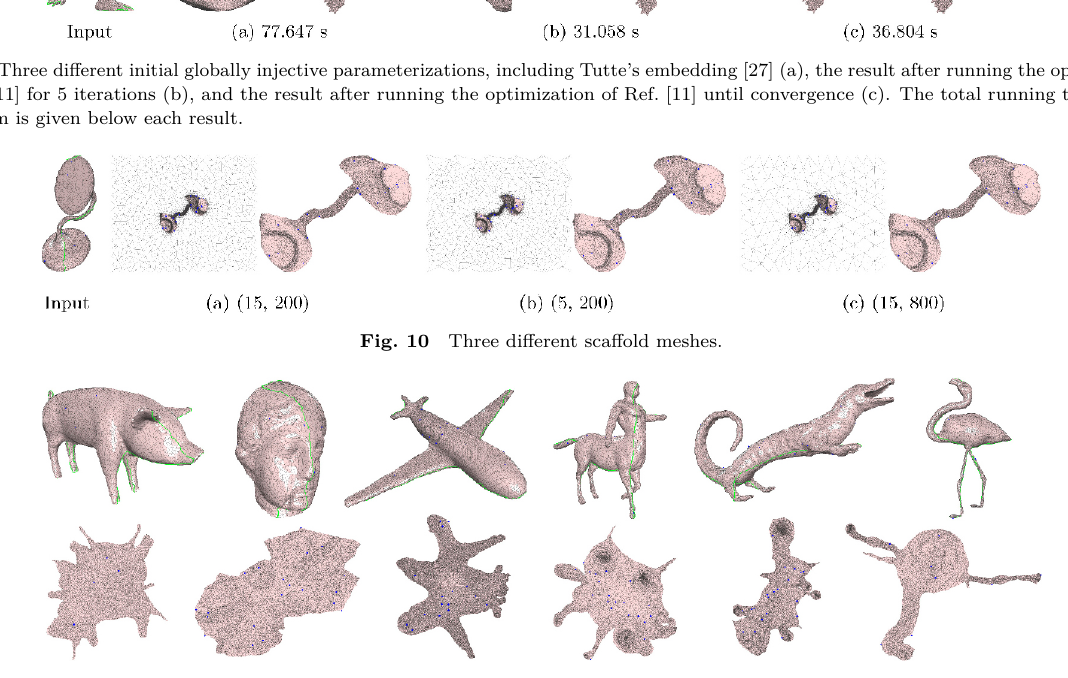
Fig. 11 Gallery: our method succeeds in generating globally injective parameterizations with hard positional